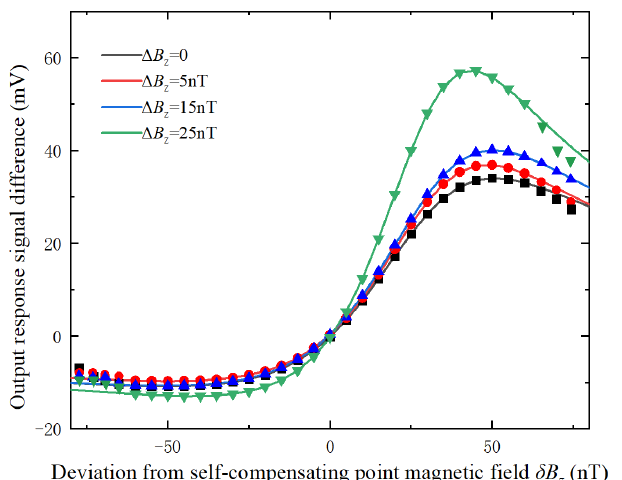
Figure 3. Experimental measurements of the stepped magnetic field modulated output response with an applied z -axis magnetic field gradient.